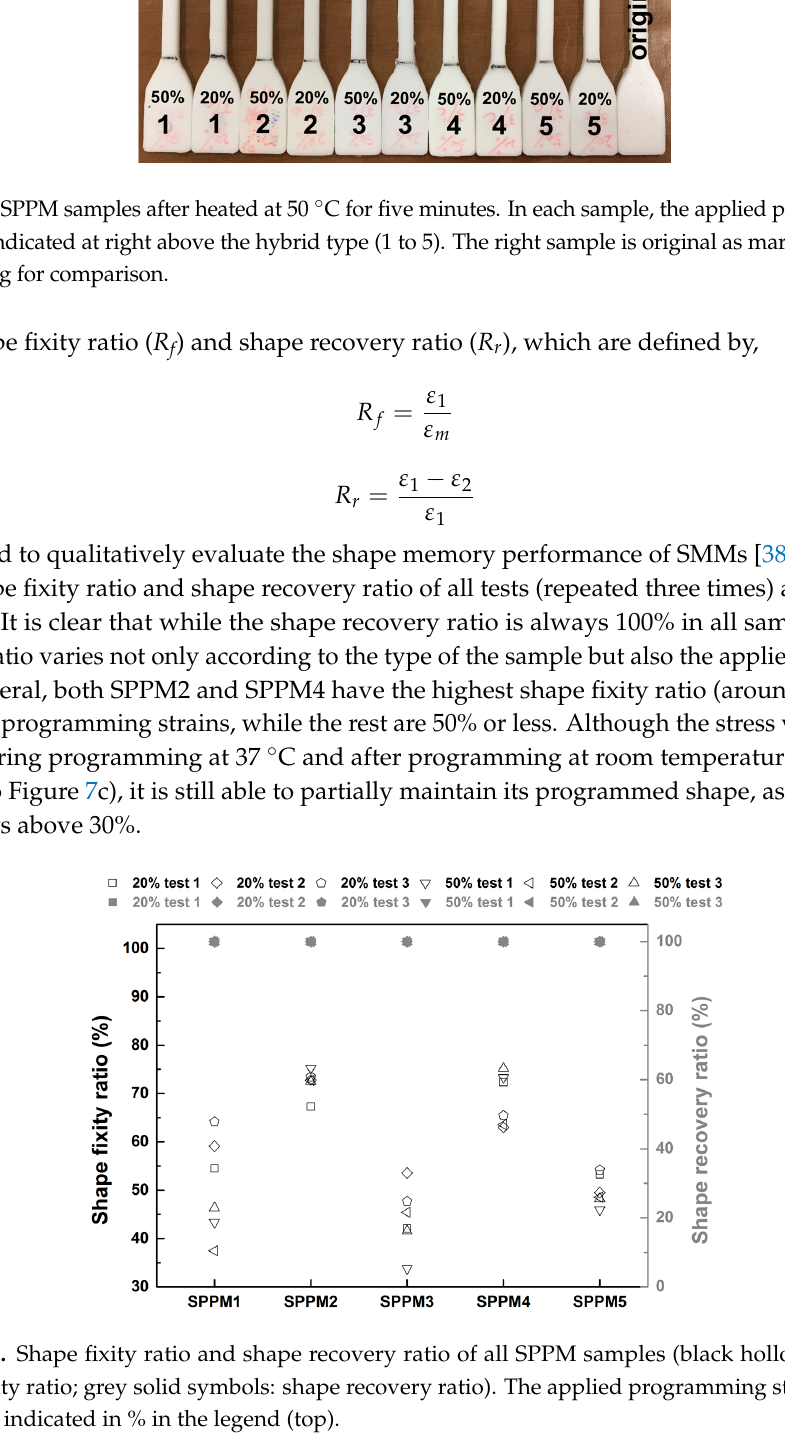
Figure 10. Shape fixity ratio and shape recovery ratio of all SPPM samples (black hollow symbols: shape fixity ratio; grey solid symbols: shape recovery ratio). The applied programming strain in each sample is indicated in % in the legend (top).